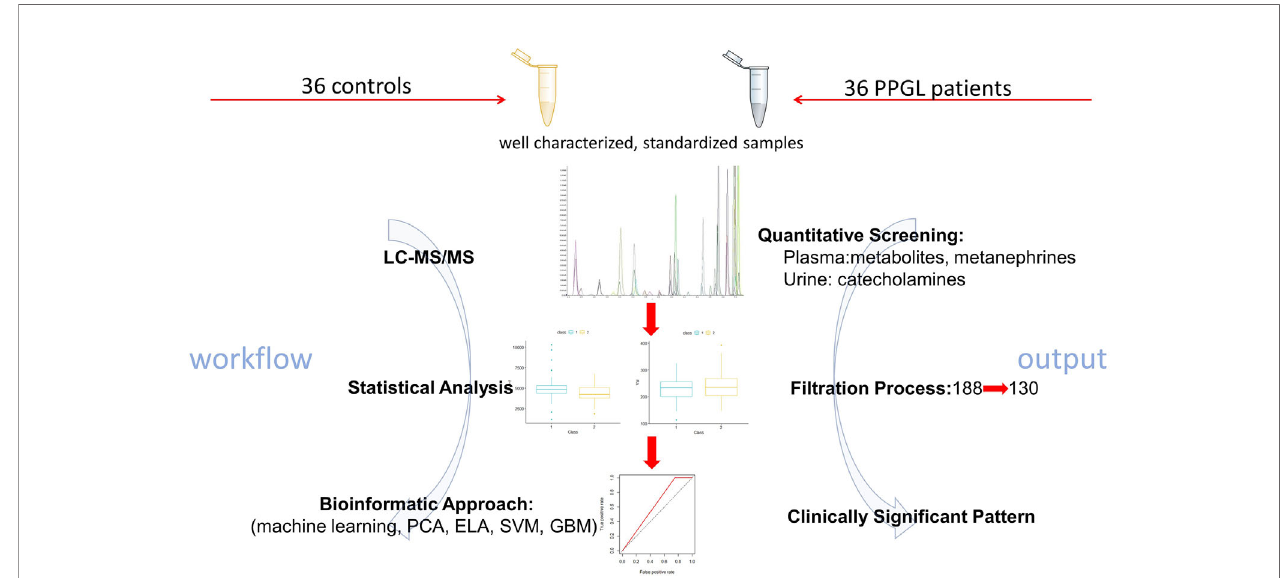
FIGURE 1 | Summary of the work fl ow leading to identi fi cation of signi fi cant metabolites via liquid chromatography tandem mass spectrometry (LC-MS/MS), in pheochromocytoma and paraganglioma (PPGL),The bioinformatic approach included Elastic net (ELA), Gradient Boosting Machine (GBM), Support Vector Machine (SVM) and Principal component analysis (PCA)